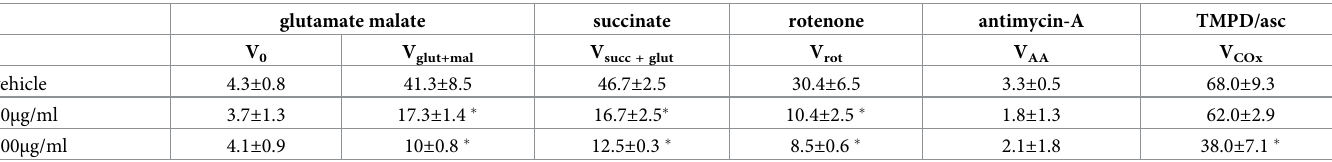
Rates of respiration are given in picomoles O 2 per second per milligram wet weight (pmol/O 2 /sec/mg) in vehicle and venom-treated cardiac preparation. See Materials and Methods for detailed description. V 0 complex I-dependent state 2 respiration; V glut+mal complex I-dependent state 3 respiration; V succ complex I+II-dependent